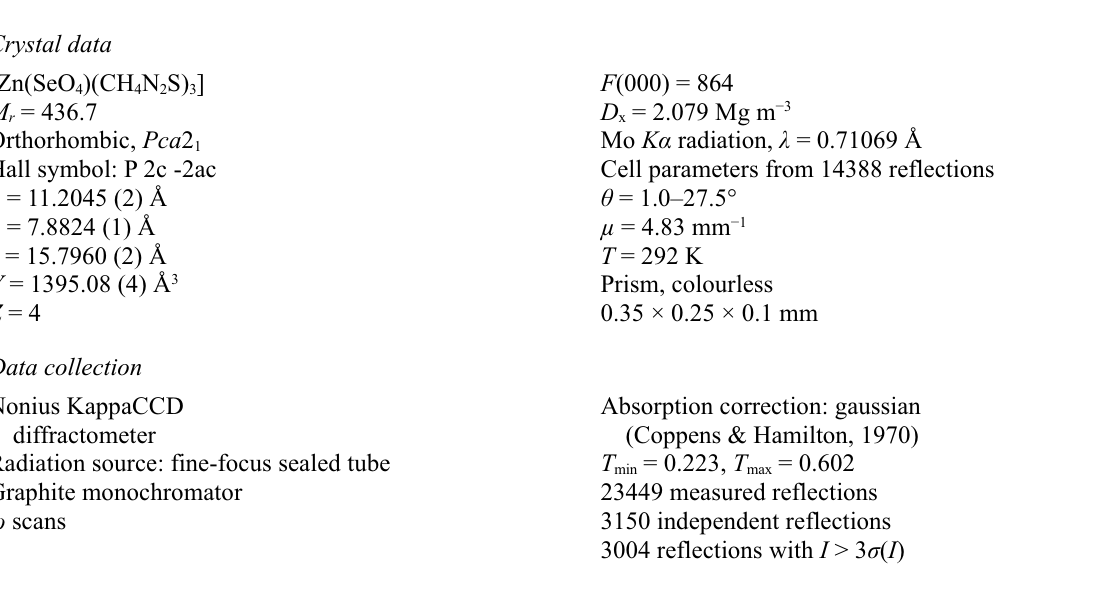
Figure 1 View of the title molecule with anisotropic displacement parameters shown at the 30% probability level. (Tetraoxidoselenato- κ O )tris(thiourea- κ S